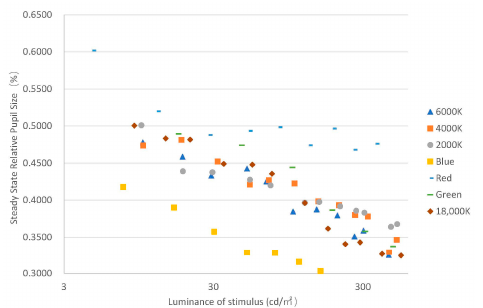
Figure 7. Steady-State of Pupil Diameter vs. Luminance of Stimulus (log scale).